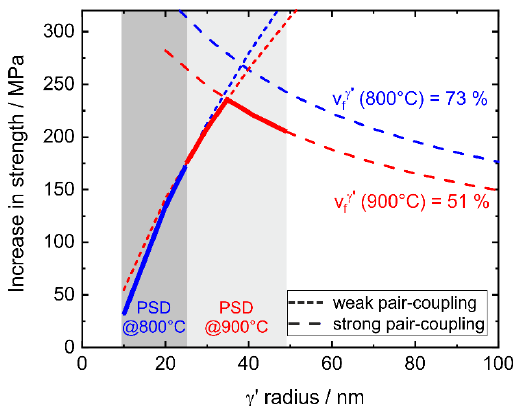
Figure 8. Dependence of the increase in strength on the mean radius of the γ (cid:48) precipitates after the first aging step at 800 °C and 900 °C. The particle size distribution (PSD) of secondary γ (cid:48) precipitates of the different conditions is marked.